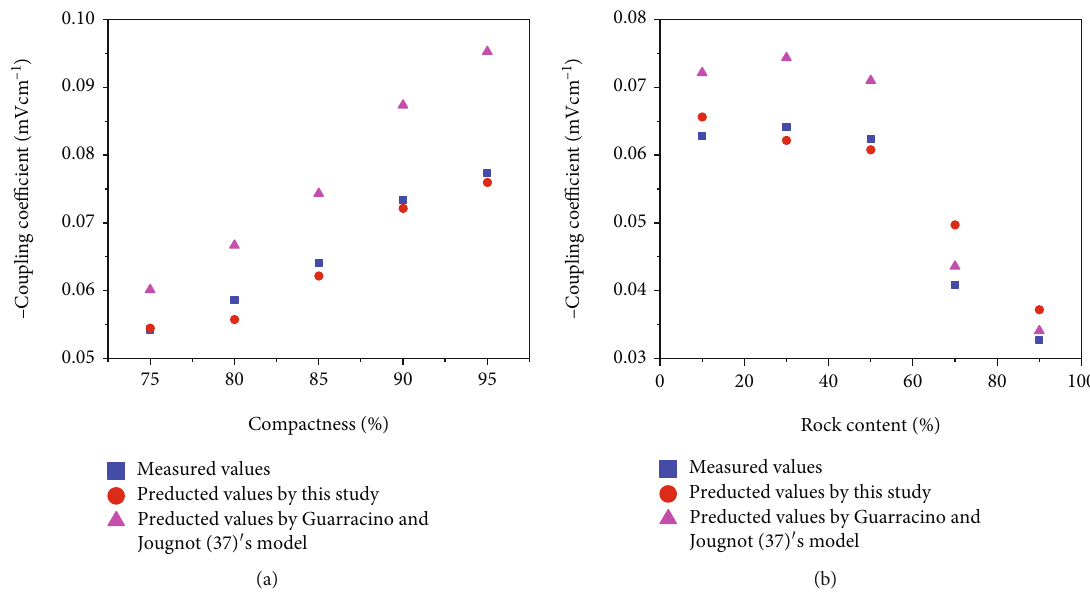
Figure 5: The streaming potential coupling coe ffi cient with di ff erent compactness and di ff erent rock content. (a) Predicted and measured values of the streaming potential coupling coe ffi cient with di ff erent compactness. (b) Predicted and measured values of the streaming potential coupling coe ffi cient with di ff erent rock